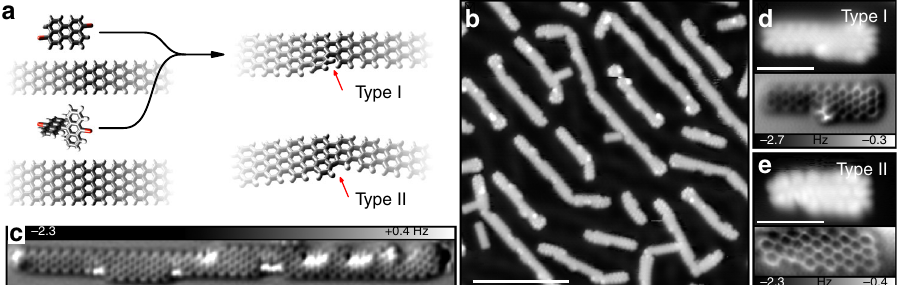
Fig. 1 Fabrication and characterization of metal-semiconductor heterojunctions and heterostructures. a Chemical structure of 10,10 ’ -dibromo-9,9 ’ -bianthryl (DBBA) and dibromoperylene (DBP), and of a 5/7-GNR heterojunction. The red arrows indicate a type I ( top ) and type II ( bottom ) junction. b Overview STM image of 5/7-GNR heterostructures on Au(111). V = 0.1 V, I = 20 pA, scale bar is 10 nm. c AFM image of a heterostructure. d Small-scale STM ( top ) and AFM ( bottom ) images of junction type I. z -offset for AFM image — 40 pm w.r.t. a STM set-point of V = 0.1 V, I = 20 pA. e Small-scale STM ( top ) and AFM ( bottom ) images of junction type II. z -offset — 40 pm w.r.t. a STM set-point of V = 0.1 V, I = 100 pA. Scale bars in c – e are 2